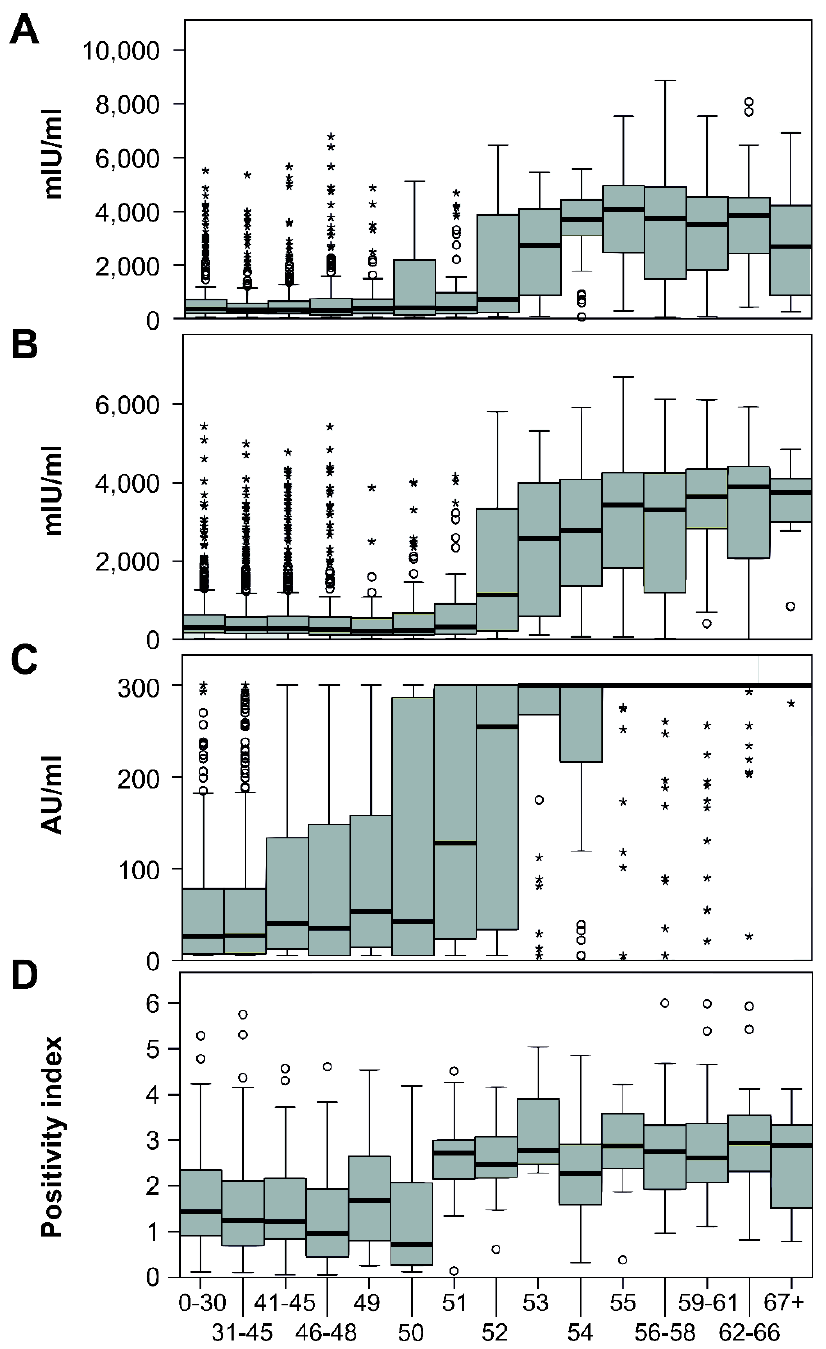
Figure 5. Distribution of test results in age groups. ( A ) AGEL lab., ( B ) Faculty Hospital, ( C ) Mikrochem lab., ( D ) Šumperk Hospital. The age groups in the charts are not uniform due to the emphasis on the trend after the age of 50. The units used differ between the first two and the third graph due to the difference in the methods used (ELISA with IU/mL vs. chemiluminescence with AU/mL). Symbols used: ( ○ ) outliers, (*) extremes.